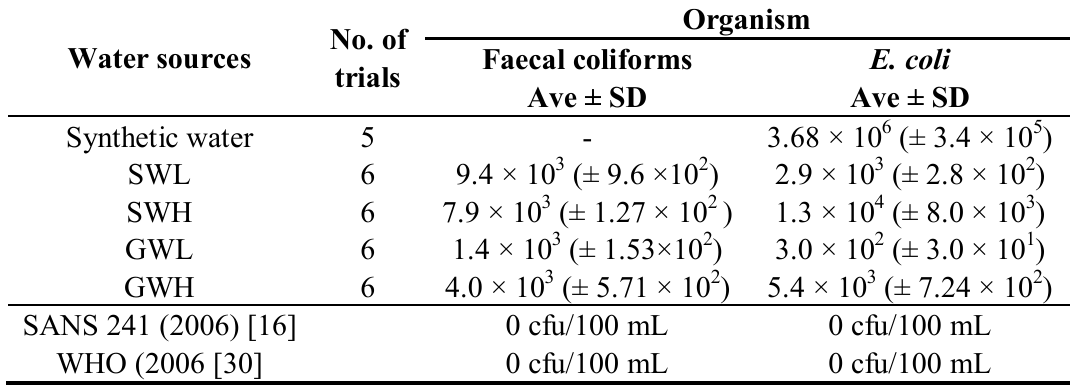
Table 5. Bacterial profile of source water samples (average ± SD cfu/100